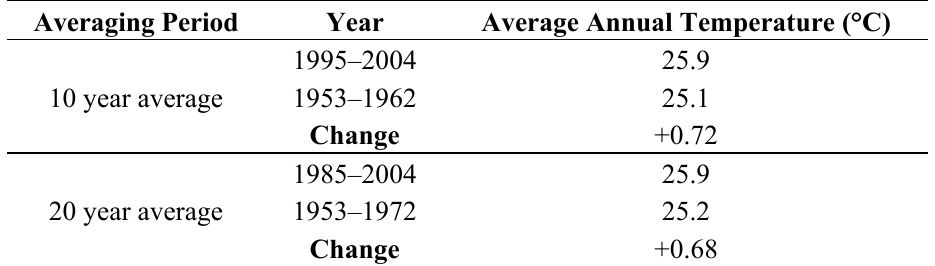
Table 1. Recorded temperature change over the years